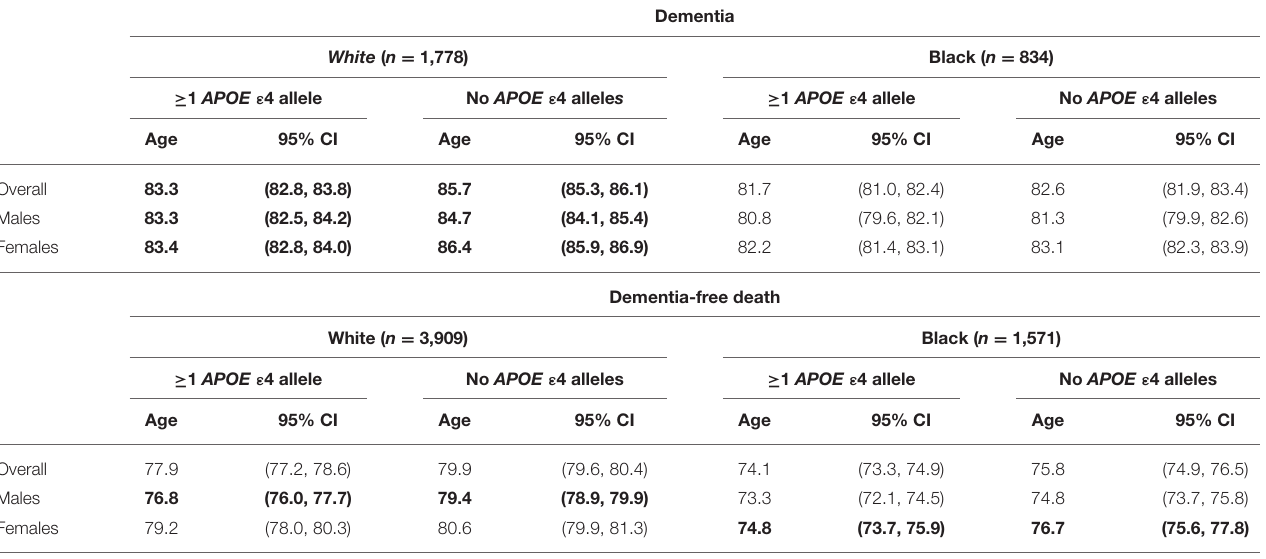
death was 73.3 years (95% CI: 72.1, 74.5) for carriers and 74.8 (95% CI: 73.7, 75.8) for non-carriers (p for difference = 0.06).